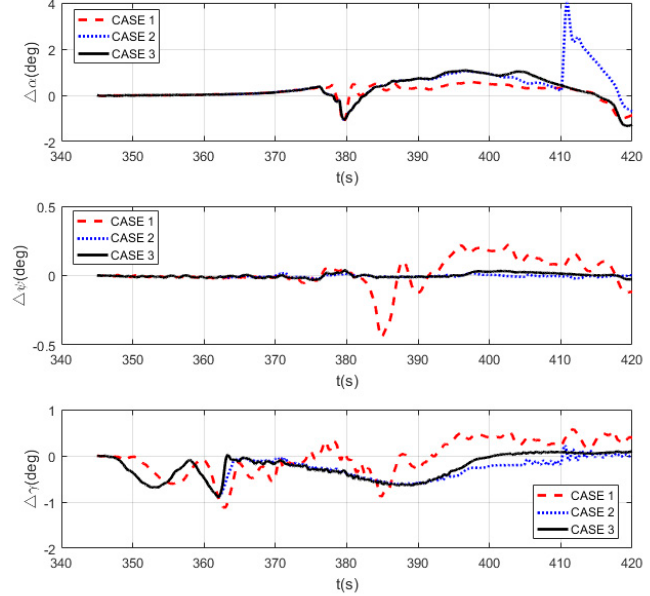
Figure 7. The control errors comparison.